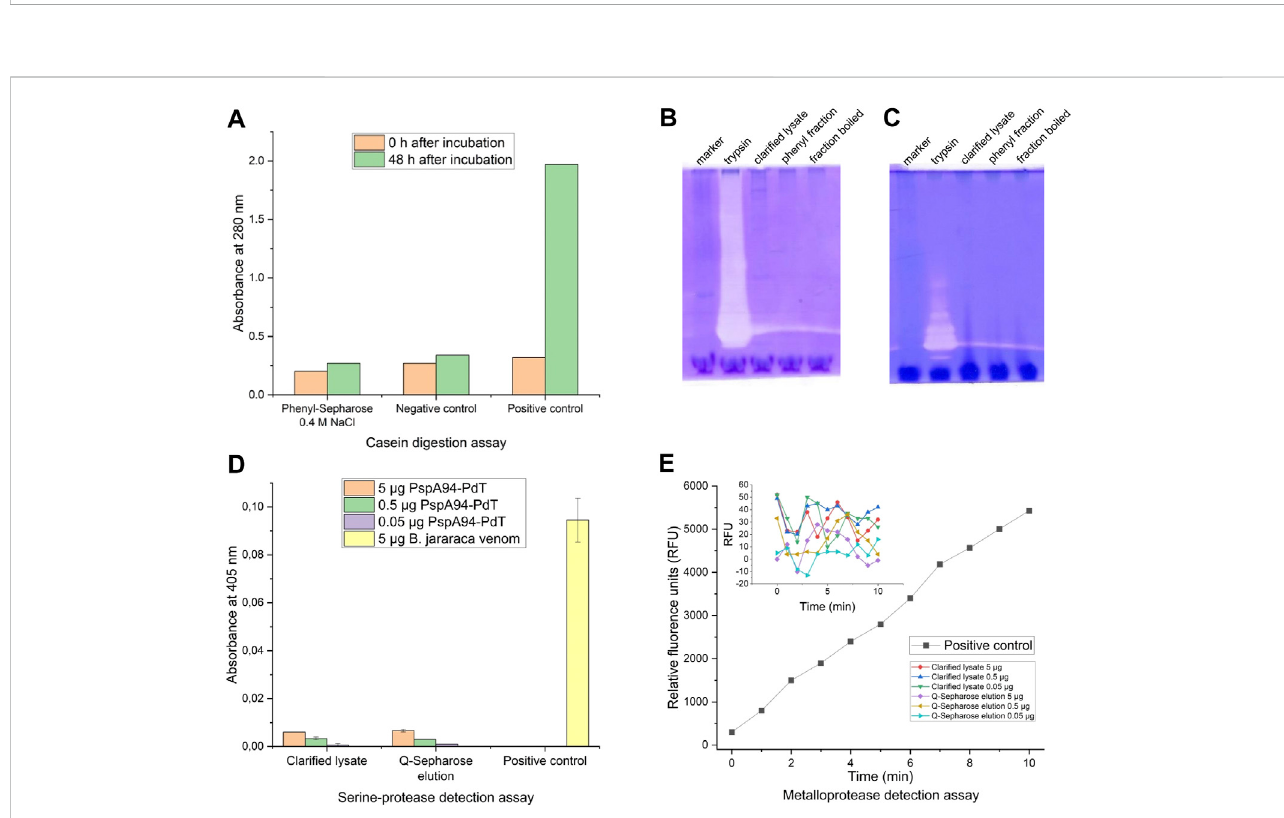
FIGURE 2 Protease activitydetection assays. (A) Caseindigestionassayfor detection ofproteolyticactivity usingpartially puri fi edsamplefrom aPhenyl-Sepharose elution fraction (0.4 M NaCl), where degradation was observed 15 days after storage at 4 ° C; trypsin (0.5 mg/mL) and distilled water were used as positive and negative controls, respectively. (B) In-gel zymography with 0.1% gelatin as substrate; lanes: molecular weight marker; trypsin as positive control; recently clari fi ed lysate; partially puri fi ed sample from a Phenyl-Sepharose elution fraction where possible degradation was observed; the same Phenyl- Sepharosefractionboiledfor10 minbeforeload. (C) SameasBbutwith0.1%caseinassubstrate; (D) Detectionofserineproteaseactivityafterincubationwith chromogenic substrate L-BAPNA in different dilutions of recently clari fi ed lysate and partially puri fi ed fraction from Q-Sepharose (0.2 M NaCl), where degradation was observed; B. jararaca venom was used as positive control. (E) Detection of metalloprotease activity after incubation with chromogenic substrate Abz-AGLA-EDDnp in differentdilutions of recently clari fi edlysate and partially puri fi edfraction from Q-Sepharose(0.2 MNaCl),where degradation was observed; isolated jararhagin from B. jararaca venom was used as positive